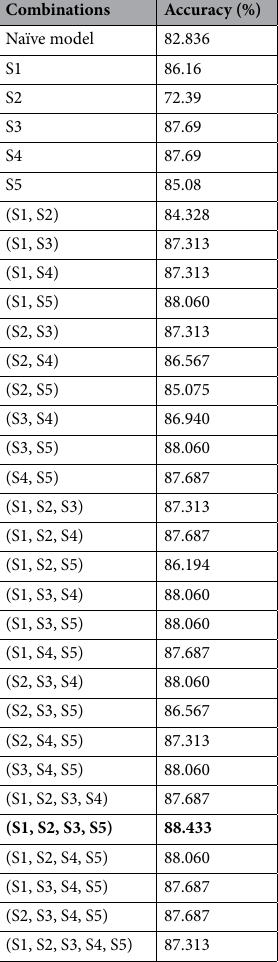
Table 3. Performance of Naïve Model and the snapshot ensemble after combining various snapshots on the test database. Bold value indicates highest result among all the snapshot conditions.